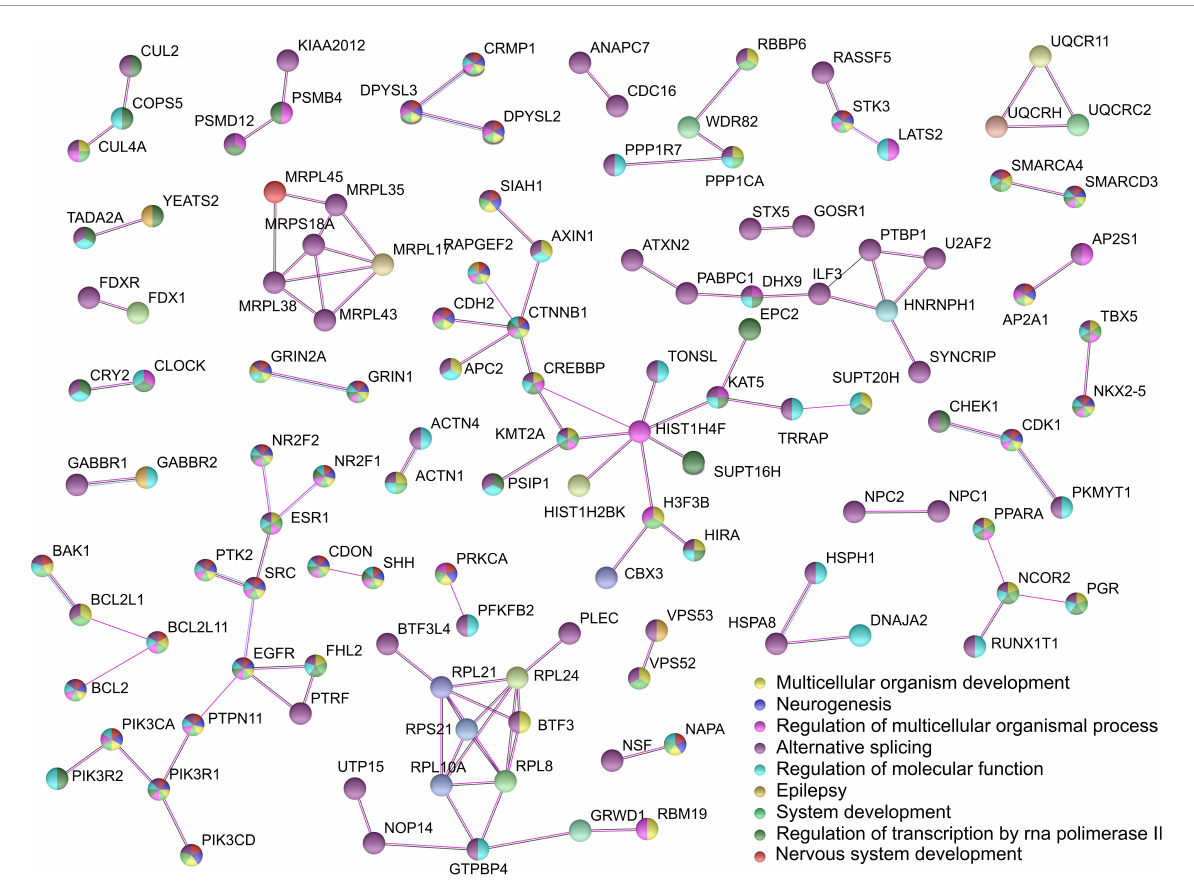
FIGURE4 Protein-protein interaction network analysis. We used STRING selecting experiments and co-expression with the highest confidence value